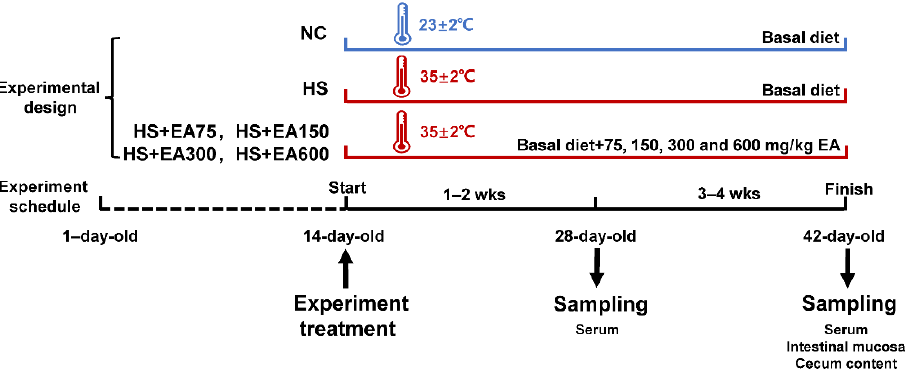
Figure 1. The experimental design and sampling schedule. Abbreviations: NC, negative control; HS, heat stress environment; EA, ellagic acid.